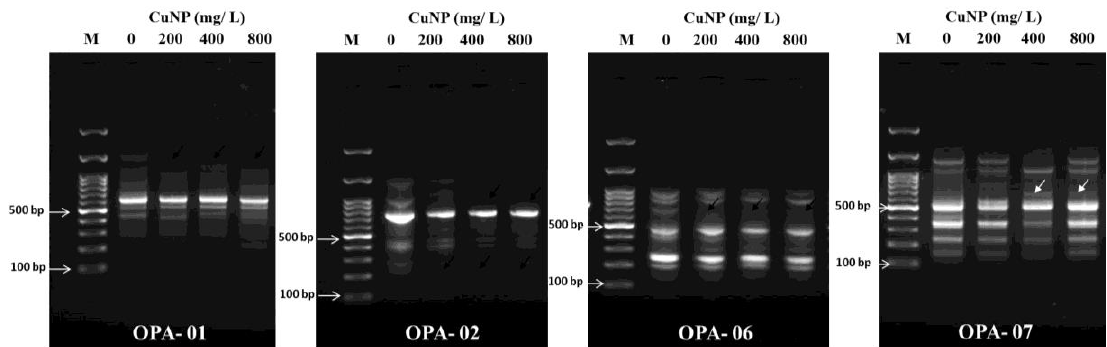
Figure 5. Random amplified polymorphic DNA (RAPD) analysis of C. sativum plants after seven days of exposure to 200 mg/L, 400 mg/L and 800 mg/L of CuNPs. All DNA of control and treated plants were amplified with OPA-1, OPA-2, OPA-6 and OPA-7. The white arrows indicate the disappearance and appearance of bands between control and treated plants.